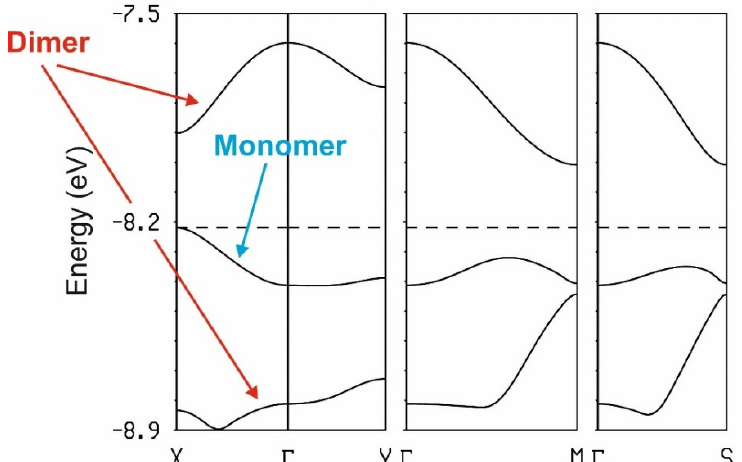
Figure 9. Calculated band structure for the donor layers of pseudo- κ″ -(BDH-TTP) 3 (ReO 4 ) 2 ( 3 ) crystals. The dashed line refers to highest occupied level and Γ = (0, 0), X = ( a */2, 0), Y = (0, b */2), M = ( a */2, b */2) and S = ( − a */2, b */2).